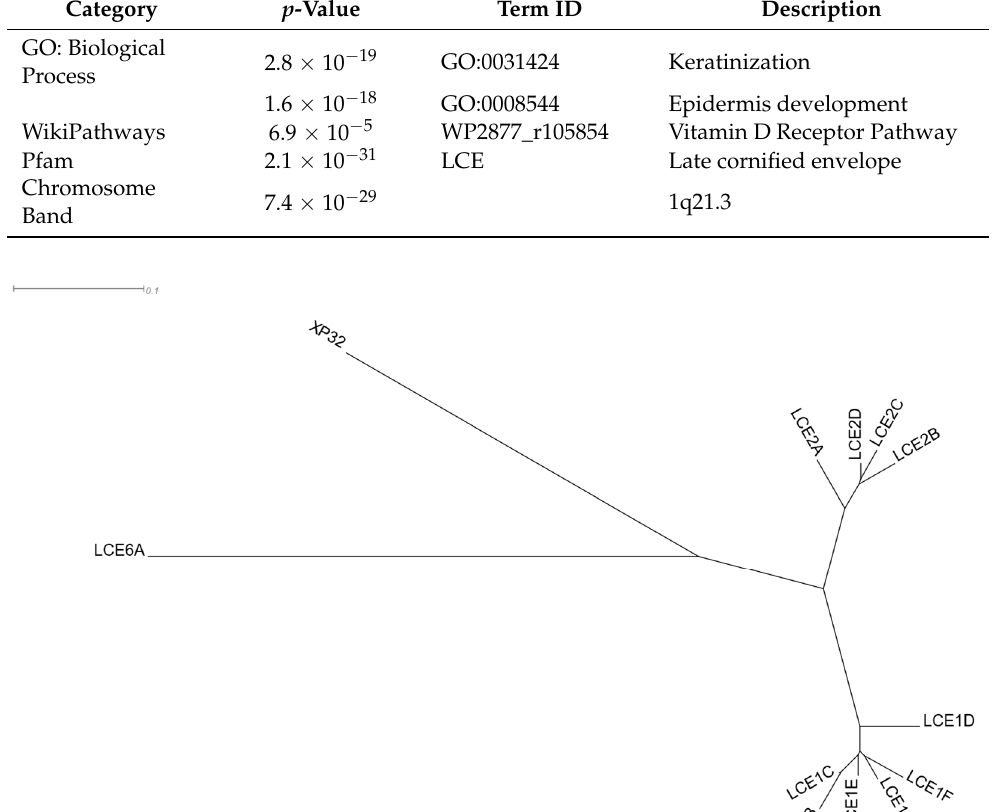
Figure 9. Phylogenetic tree resulting from MUSCLE multiple sequence alignment of the protein se- quences of the genes of the HGCA2.0 C1orf68 (XP32) coexpression clade, as viewed by Dendroscope [91] .